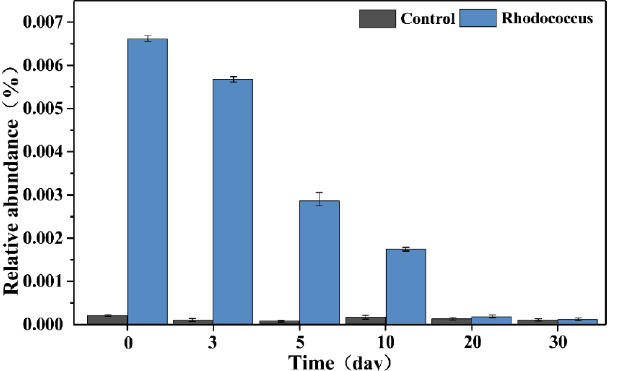
Figure 6. Abundance of biofortified Req-001.